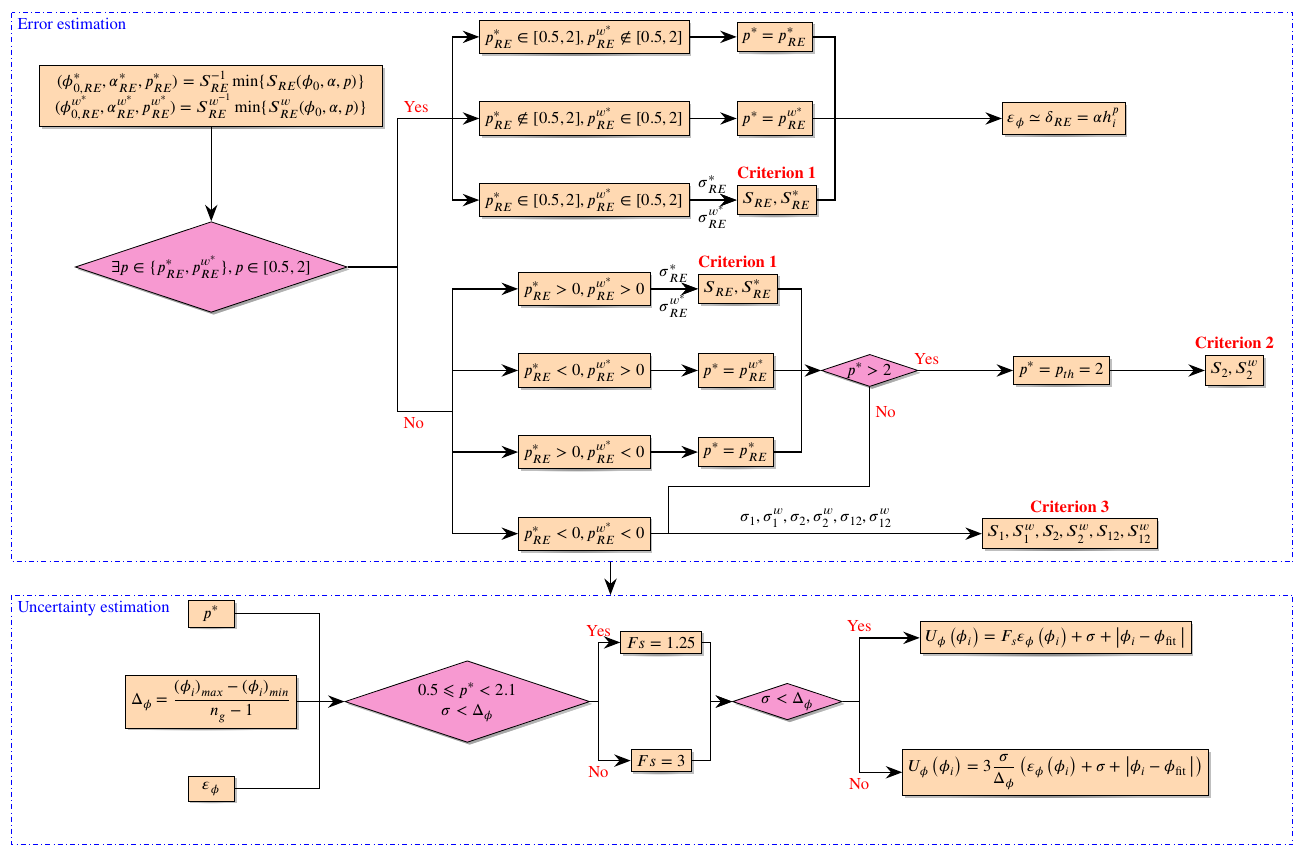
Figure 7. Procedure for error and uncertainty estimations by GCI-LSR method recommended by Eça and Hoekstra [31], De Luca et al.